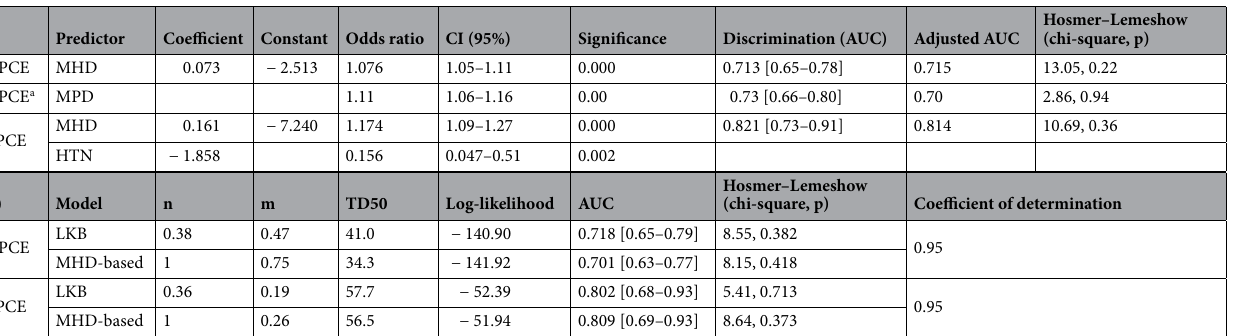
Table 2. NTCP models for A-PCE and S-PCE by logistic regression analyses (2a) and by probit regression analyses (2b). A-PCE: pericardial effusion in any grade; AUC: area under the curve; CI (95%): 95% confidence interval; HTN: hypertension; LKB: Lyman–Kutcher–Burman; MHD: mean heart dose; MPD: mean pericardial dose; NTCP: normal tissue complication probability; S-PCE: symptomatic pericardial effusion; TD50: dose that corresponds to a 50% risk of complications when the whole organ is irradiated. a A-PCE indicates